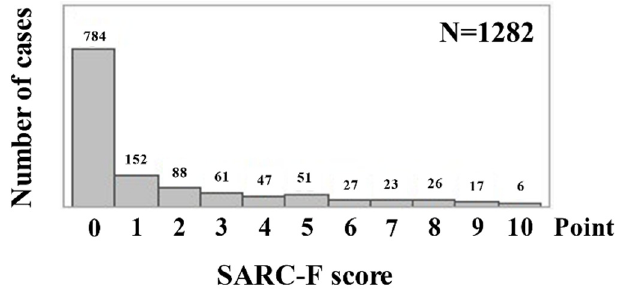
Figure 1. Number of patients according to SARC-F score.